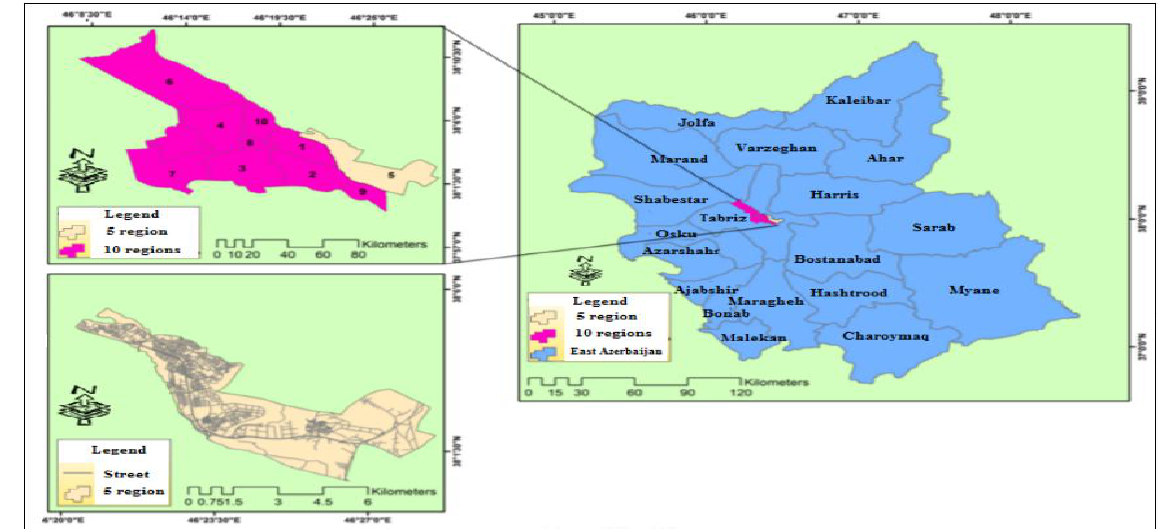
Figure 1. Map of the 5 th district of Tabriz, East Azerbaijan